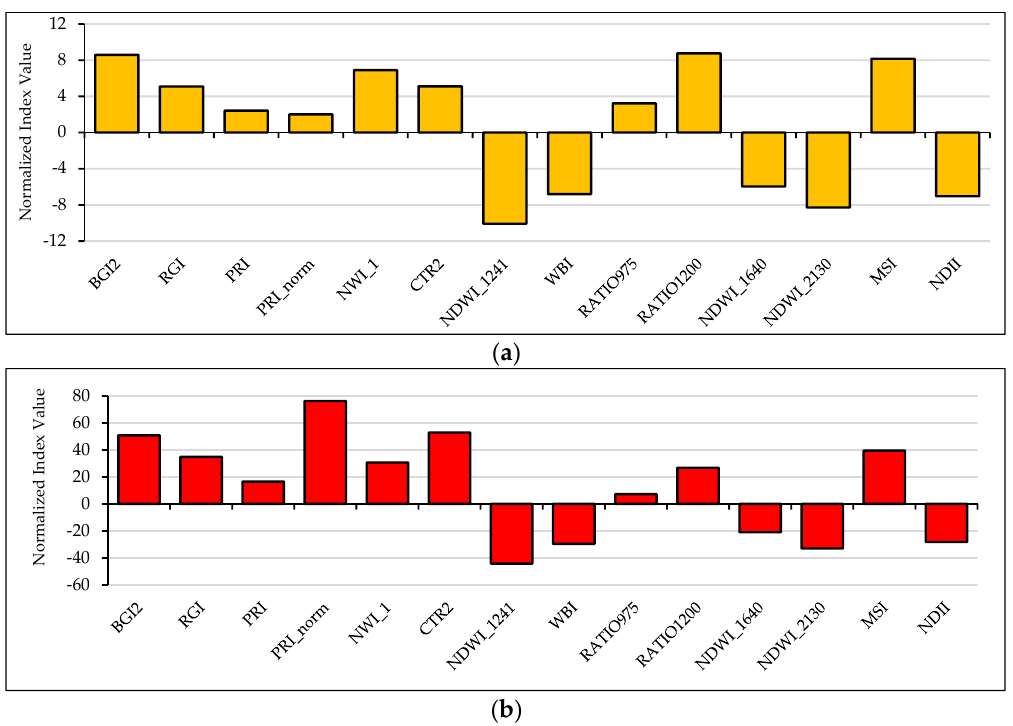
Figure 6. Normalized changes of vegetation indices in the stressed group (compared to the control group). ( a ) At day 11 (short-term stress); ( b ) At day 36 (long-term stress).